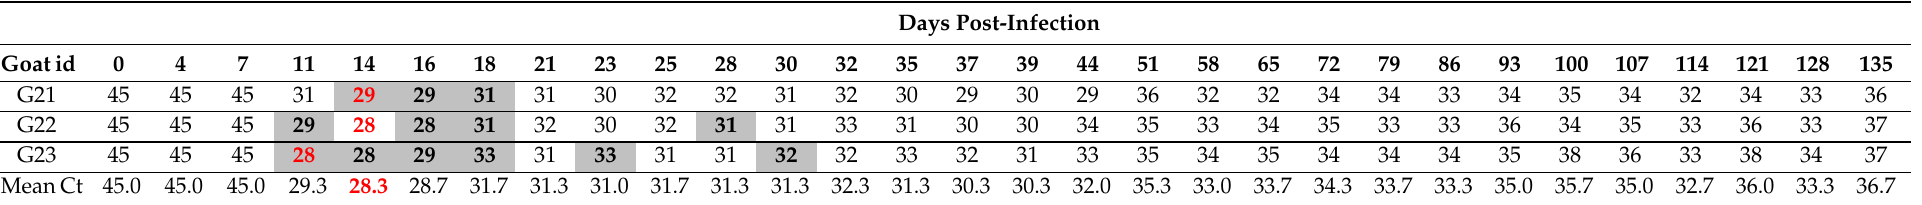
Table 2. Real-time RT-PCR threshold cycles (Ct) in the blood samples of the three goats intravenously infected with BTV-X (Trial 2). Negative samples are shown as 45. Bold red numbers represent the peak Ct for the goat and the group. Shaded boxes indicate samples from which virus was isolated on cell culture. Days Post-Infection